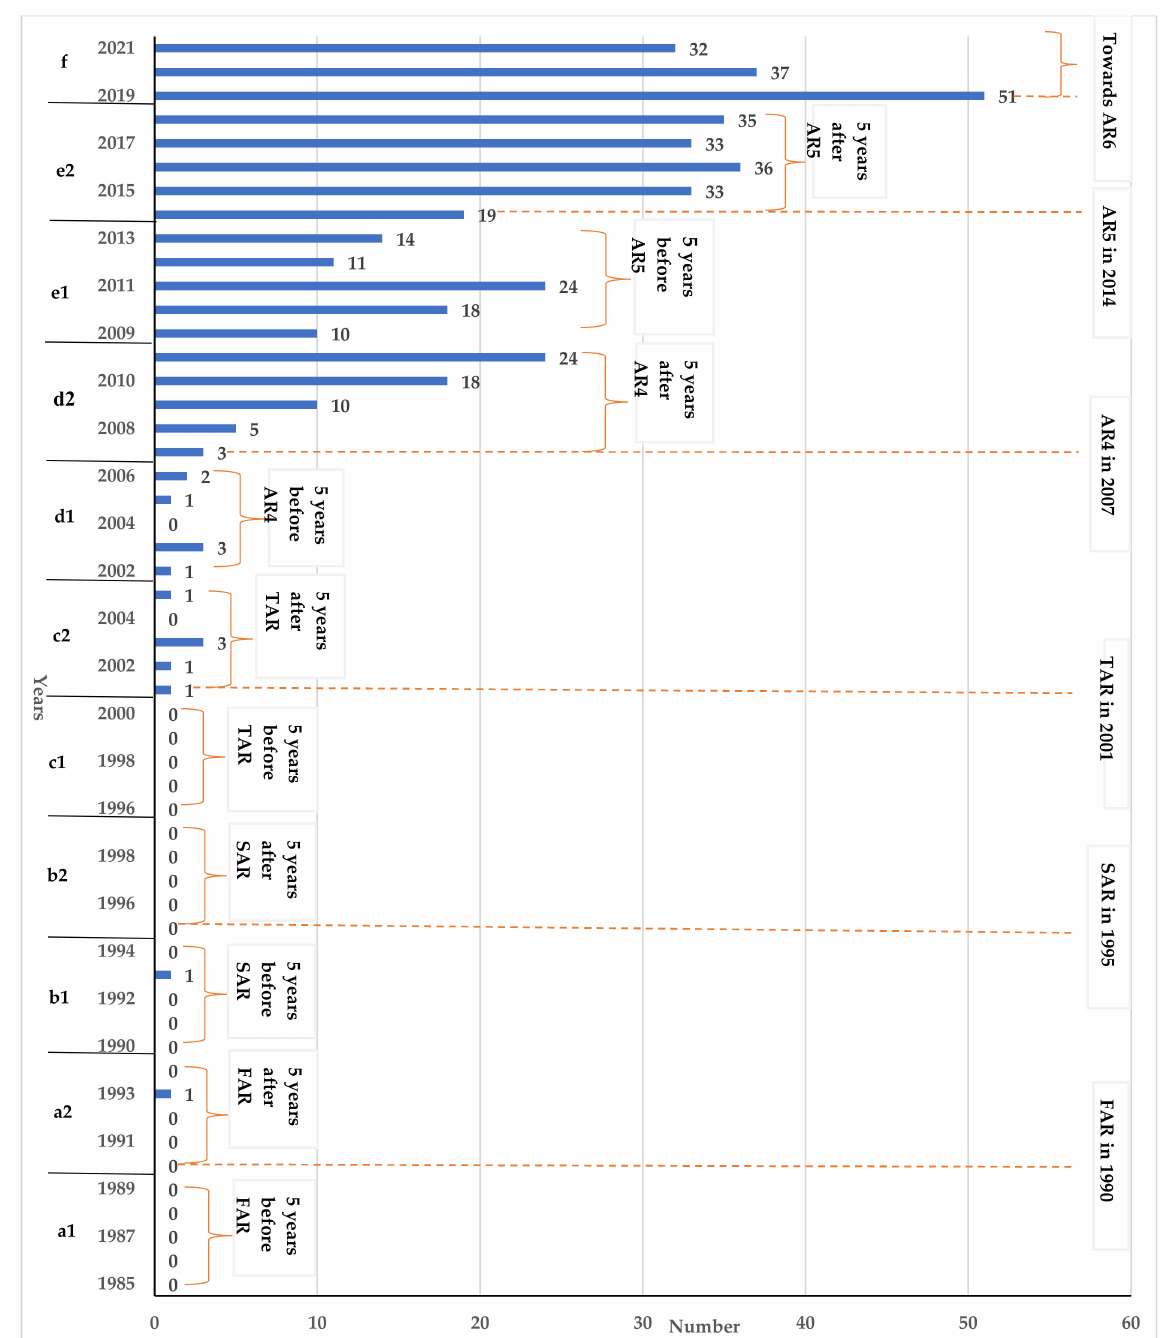
Figure 3. Number of studies 5 years before and 5 years after the release of FAR ( a1 , a2 ), SAR ( b1 , b2 ), TAR ( c1 , c2 ), AR4 ( d1 , d2 ), AR5 ( e1 , e2 ), and towards AR6 ( f ). Note: The 5 years after analysis include the year of release of the IPCC